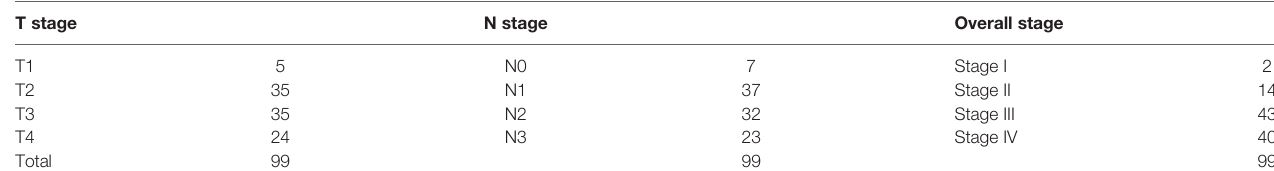
TABLE 1 | The 7th UICC/AJCC clinical stage information of 99 nasopharyngeal carcinoma patients. T